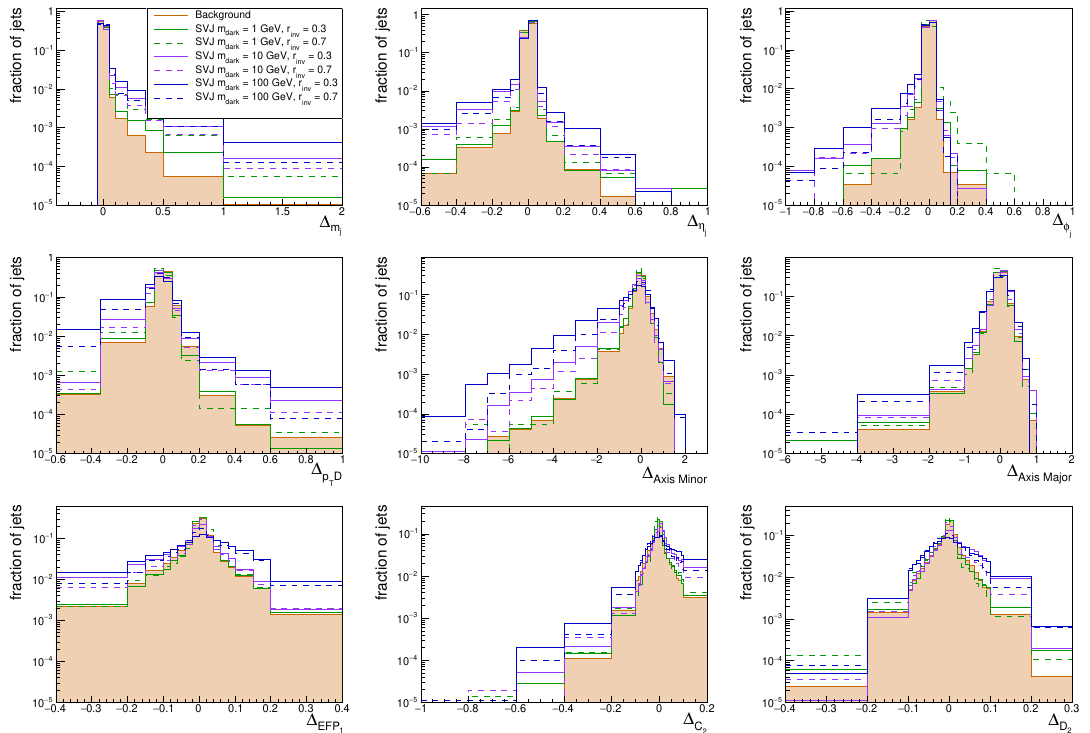
Figure 10. Distributions of difference between input and reconstructed jet features for QCD and signal models at m = 3 TeV and varying m dark and r inv Z 0